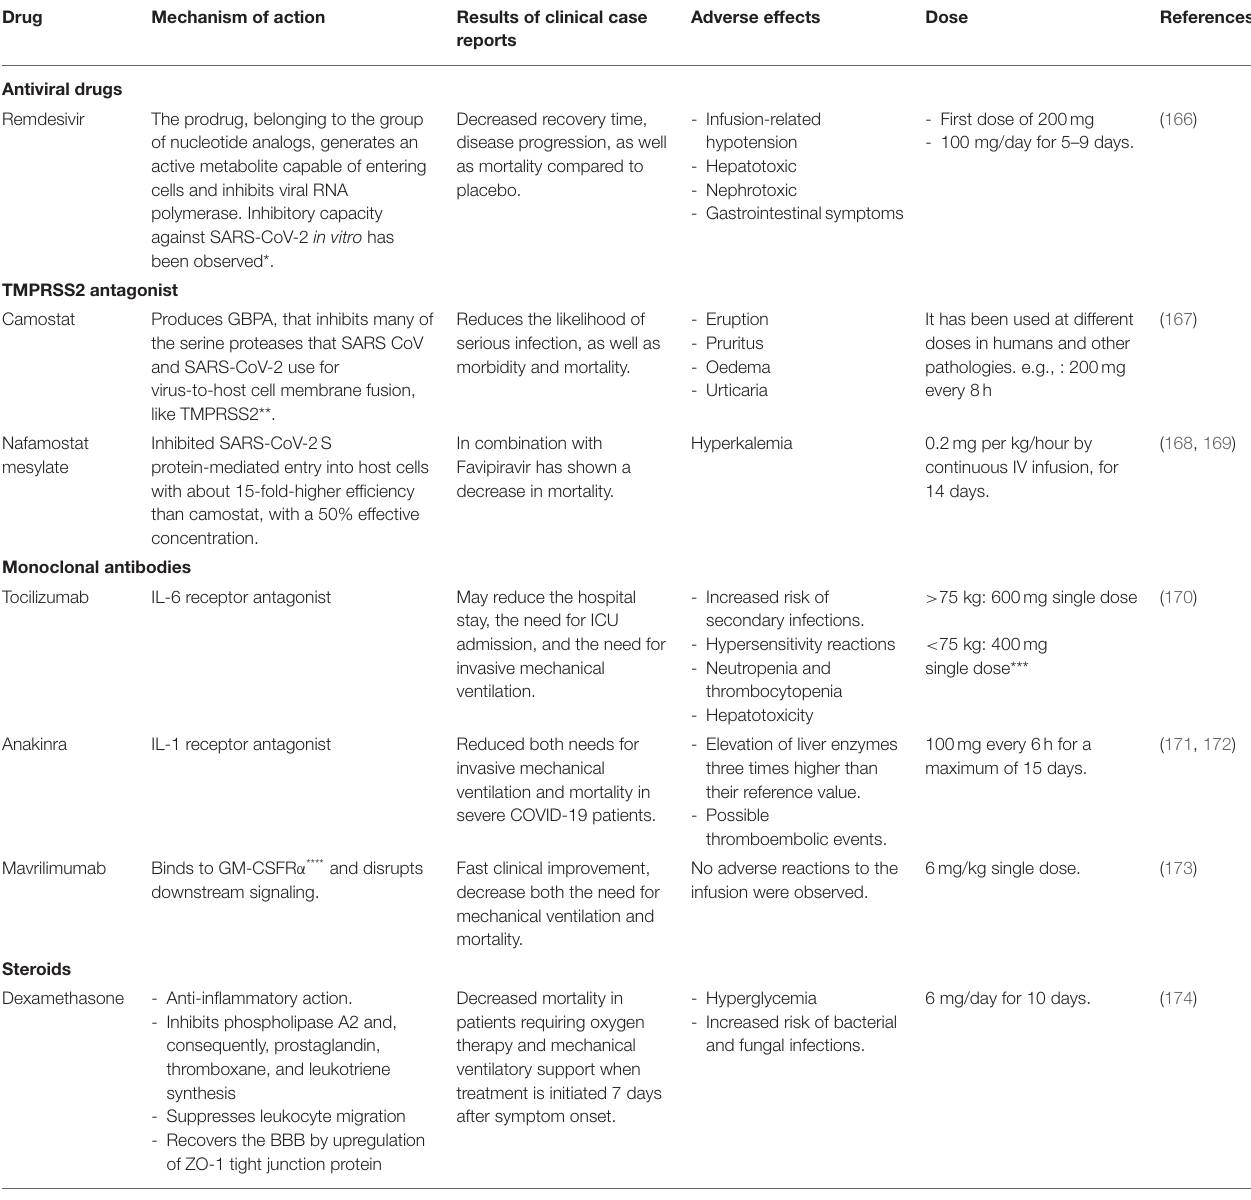
TABLE 3 | Current drugs used against